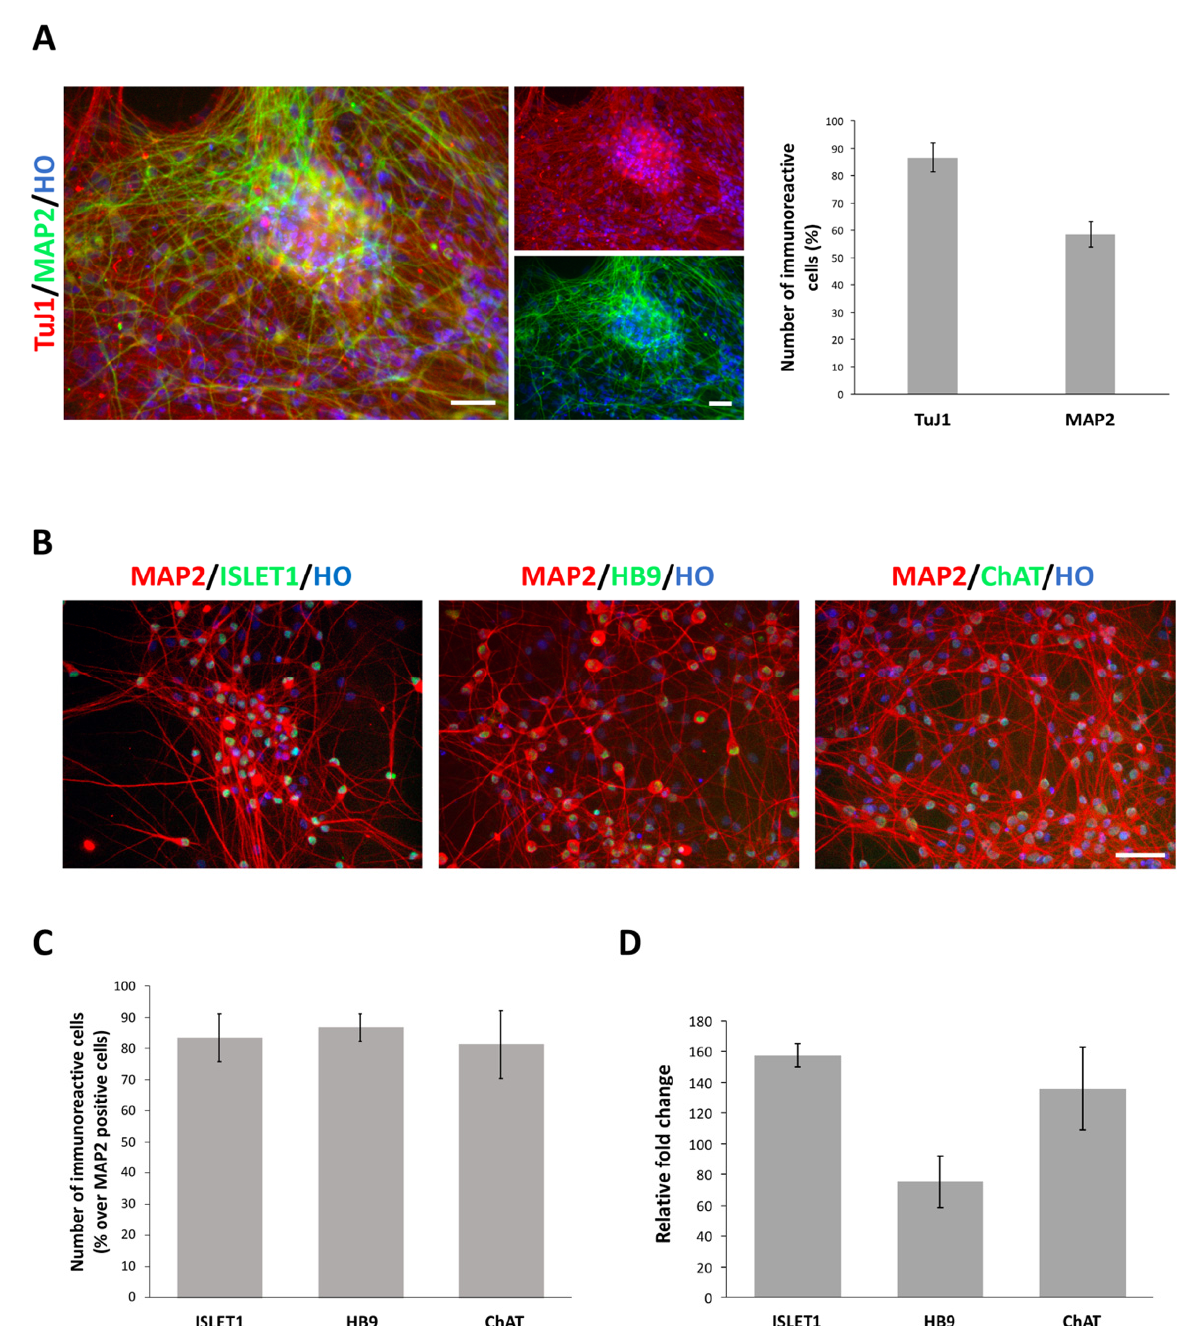
Figure 3. MNPCs efficiently differentiate into MNs when exposed to 4 weeks of neuronal maturation conditions. ( A ) Representative pictures of 4-weeks cultures showing that the population is nearly homogeneously composed by neuronal cells immunoreactive for Tuj1 (top right panel), MAP2 (bottom right panel) along with merged picture (left panel). Nuclei are stained with Hoechst (HO). Scale bar: 100 μ m. The graph reports the quantification of TuJ1 and MAP2 immunoreactive cells in culture over the total number of cells assessed by HO staining. ( B ) Representative pictures of ISLET1, HB9 and ChAT immunoreactive MNs. Nuclei are stained with Hoechst (HO). Scale bar: 50 μ m. ( C ) Graphs showing number of ISLET1-, HB9- and ChAT-positive cells over the total number of MAP2 immunoreactive cells (lower panel). ( D ) qPCR analysis for ISLET1, HB9 and ChAT transcript levels. Data are expressed as the means ± STDV ( n = 3 biologically independent experiments).